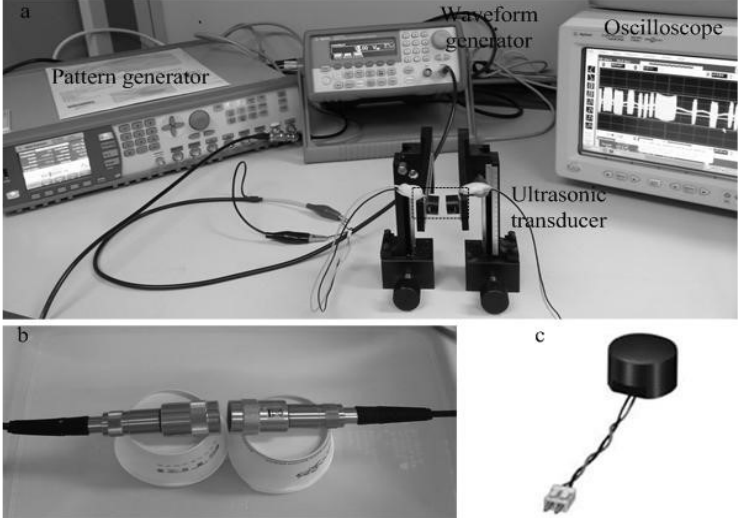
Figure 3. ( a ) Experimental setup; ( b ) Transducer for frequency shift keying (FSK) modulation; ( c ) Transducer for amplitude shift keying (ASK), and phase shift keying (PSK) modulation.